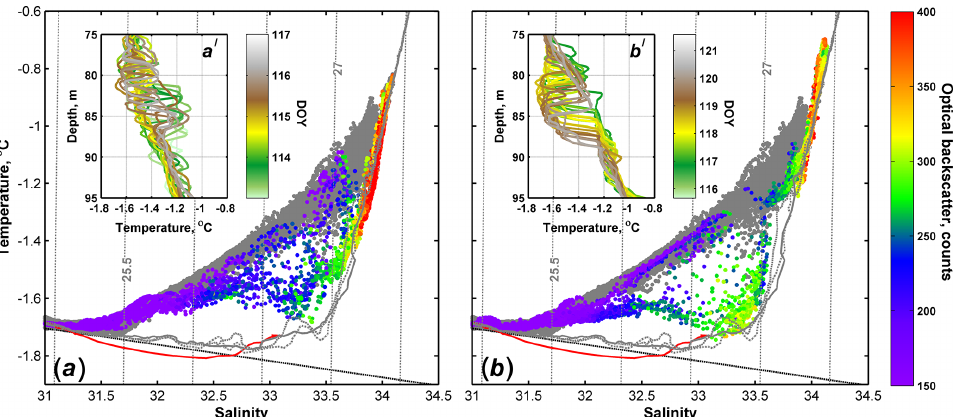
Figure 7. The TS scatterplot for events (a) A and (b) B when the active interleaving was observed (see Fig. 2) with optical backscatter intensity (colour bar). The grey dots correspond to the TS measured after 30 April, 12:00UTC (DOY 120.5). The red and grey curves show the TS profile(s) measured near the glacier in August 2015 (no. 166) and within the debris of glacier terminus in April 2016 (nos. 26, 27, and 28), respectively. The inserts a (cid:48) and b (cid:48) show the subset of temperature profiles during each episode. Dashed grey lines are σ -zero isopycnals in kgm − 3